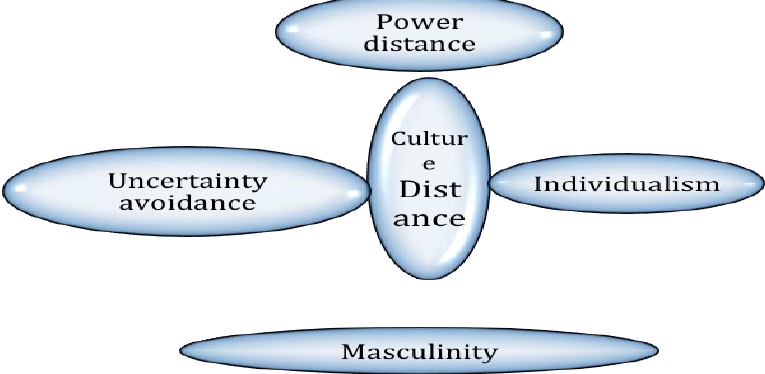
Figure 3. Dimensions of Cultural